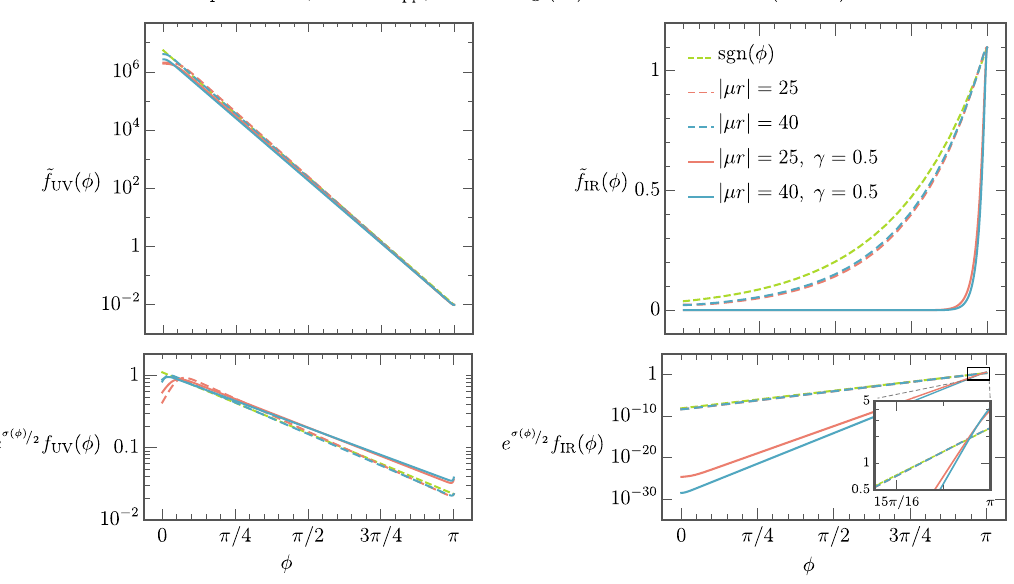
Figure 9 . Examples of pro(cid:12)les of fermion zero modes obtained in the original RS model (green), i.e. using a sgn( (cid:30) ) function in front of the bulk masses, and in the model where the bulk masses are generated dynamically through the VEV of a scalar (cid:12)eld, considering both strong and no backreaction (solid and dashed lines, respectively). We use the background solutions shown in (cid:12)gure 6. The left (right) panels show pro(cid:12)les which are localized near the UV (IR) brane. In each case, we adjust the dimensionless couplings c such that the values of the pro(cid:12)les on the IR brane are the same in all cases, with F ( c ) = ~ f ( (cid:25) ) = 0 : 01 and 1 : 1 for the left and right panels, respectively. In the upper panels we show the rescaled pro(cid:12)les ~ f ( (cid:30) ) de(cid:12)ned in (5.10), whereas the lower panels display the \properly normalized" solutions e (cid:27) ( (cid:30) ) = 2 f ( (cid:30) ), see text for more